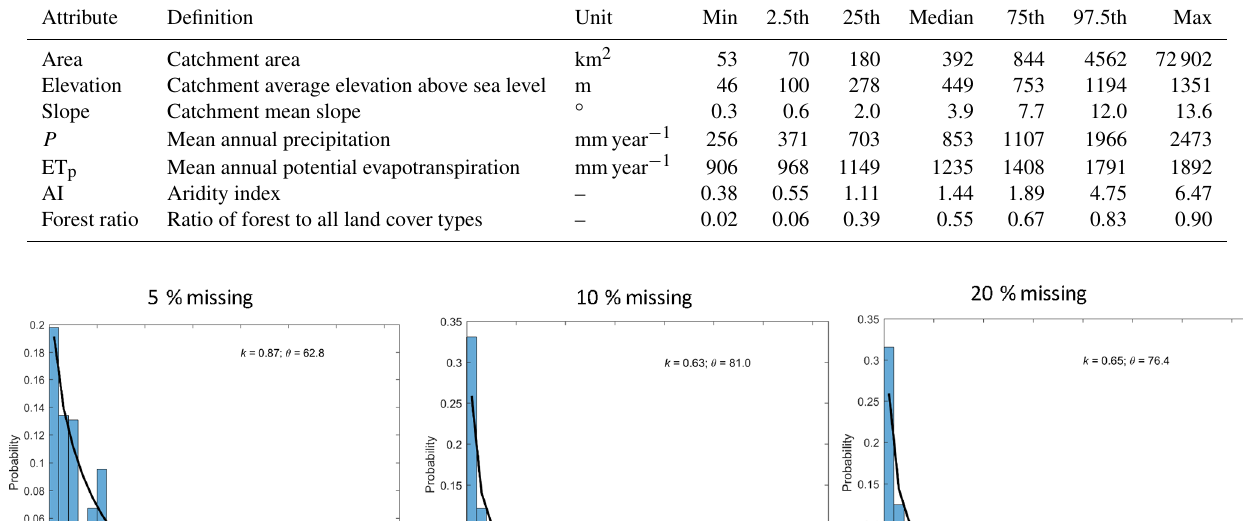
Table 1. Major catchment attributes for the 217 catchments.